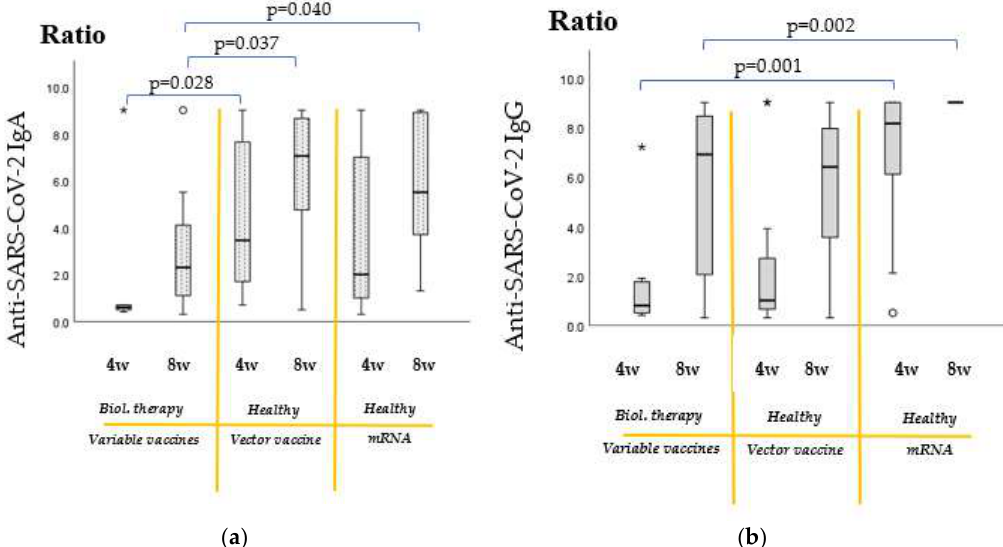
Figure 4. ( a ) Comparison of anti-SARS-CoV-2 IgA titers of recipients of immunomodulatory therapies with untreated individuals. ( b ) Comparison of anti-SARS-CoV-2 IgG titers of recipients of immunomodulatory therapies with untreated individuals.Anti-SARS-CoV-2 IgA and IgG antibody titer results were expressed as a ratio of the extinction of the patient sample (or control) over the extinction of the calibrator. Ratio < 0.8—negative; ratio ≥ 0.8 to 1.1—borderline; and ratio > 1.1—positive. Patients of variable vaccination backgrounds receiving biological therapies (Supplementary Table S1) were compared with healthy, untreated recipients of vector vaccines and healthy, untreated recipients of mRNA vaccines. They were compared at 4 and 8 weeks post-vaccination. For the sample measure- ment and subsequent data analysis, three venipunctures have been performed: time point zero was used as a negative control (on the day of immunization and before vaccine administration, when there were no detectable antibody levels; data is not shown), followed by time point one (4 weeks post- vaccination) and time point two (8 weeks post-vaccination). (For vaccine group nomenclature used for the figures, please see Supplementary Table S2.)The sample numbers were as follows: untreated, healthy individuals and recipients of the mRNA vaccine (Moderna and Pfizer–BioNtech) = 22. Un- treated, healthy individuals and recipients of vector vaccines (AstraZeneca and Sputnik V) = 16. Biological therapy-treated patients with mixed vaccination backgrounds (Pfizer–BioNtech, Moderna, Sputnik V, AstraZeneca and Sinopharm) =